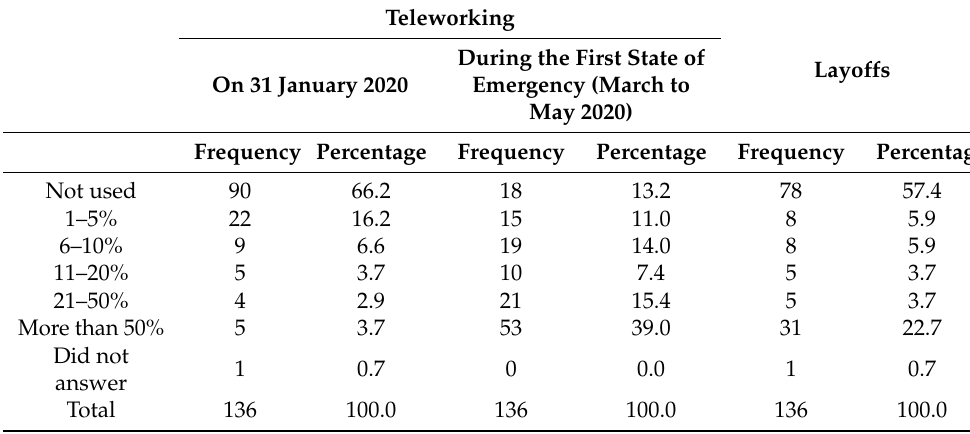
Table 1. Work situations with the greatest changes—teleworking and